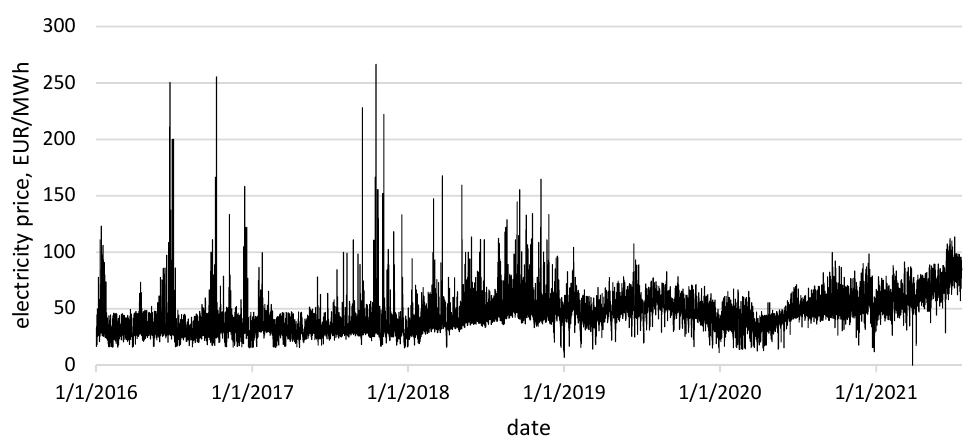
Figure 3. A day-ahead electricity price TGE—POLPX Warsaw 2016–2021 [31]. In 2020, COVID-19 contributed to relatively low energy prices. From the turn of 2020/2021, energy prices are strongly influenced by the cost of CO 2 emission rights, as 1 MWh of electricity in Polish conditions involves an average emission of about 0.75 Mg of CO 2 . At current prices, emission rights alone are worth at least 40 EUR per 1 tonne of emitted CO 2 (July 2020), i.e., about half of the monetary value of energy. In addition, energy prices are affected by the introduction of the capacity market in Poland [32,33]. For the above reasons, considering the prices on the energy market prior to 2021 was insignificant. A detailed price was analysed in the period from 5 April 2021 in the scope of day-ahead and intraday market. These prices are shown in Figure 4. and additionally, prices on the German market were taken into account to show the scale of possible price changes in the future on the basis of a market with a higher RES share (Poland is aiming for a higher RES share in the energy mix) [32,34].